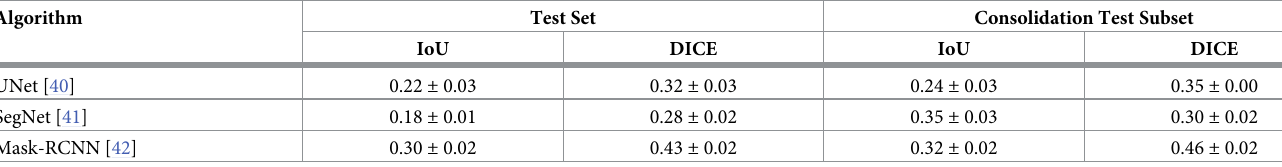
Table 3. Evaluation of existing deep learning models for COVID-19 semantic segmentation.